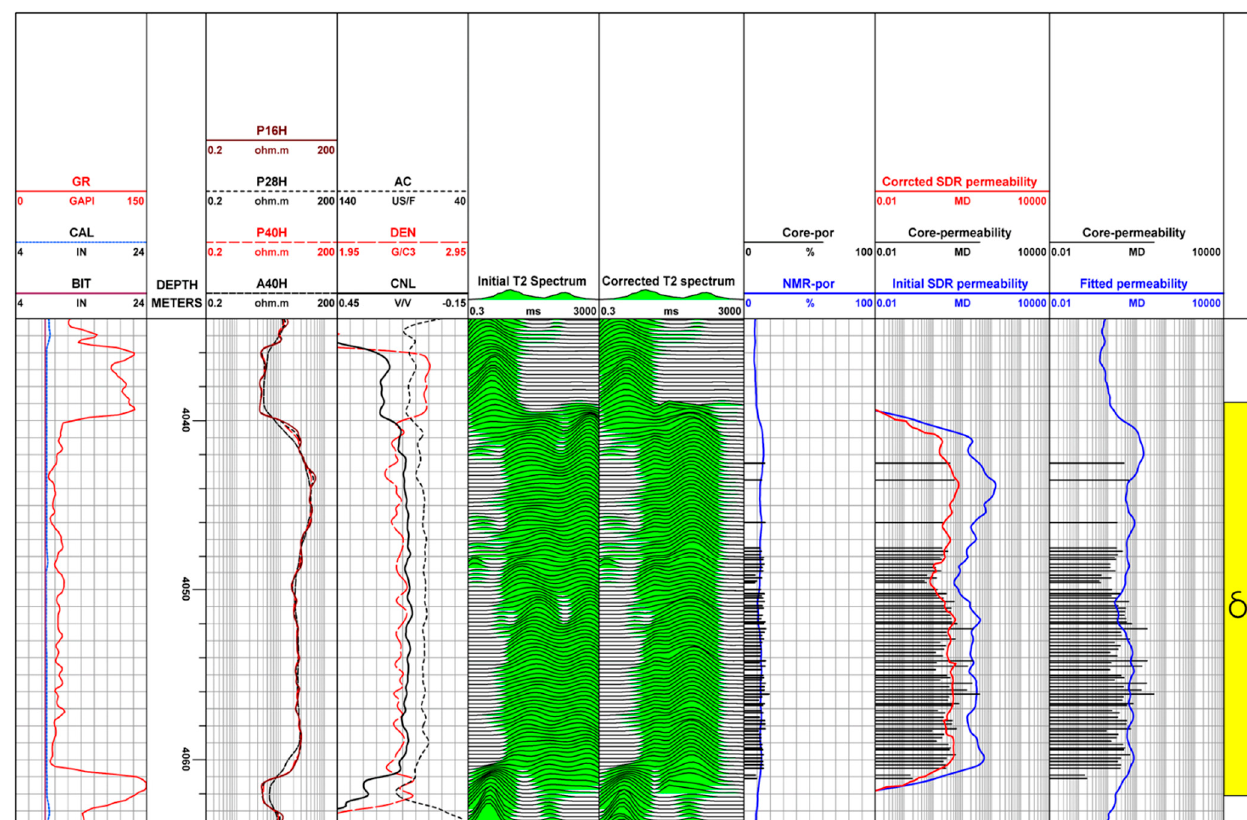
Figure 7. A field example of correcting the invasion of oil-based mud to field NMR logging in well B. In the first track, the displayed curves are gamma-ray (GR), borehole diameter (CAL), and bit diameter (BIT). The second track is the depth. The third is resistivity curve. The acoustic transit time log (AC), the density log (DEN), compensated neutron log (CNL) are shown in the fourth track. The fifth track is the initial measured T 2 spectrum of NMR logging before correction (Initial T 2 spectrum). The T 2 spectrum of nuclear magnetic resonance logging (Corrected T 2 spectrum) under the condition of water-based mud corrected by the method proposed in this study is displayed in the sixth track. The NMR calculated porosity (NMR-por) and core analysis porosity (Core-por) are shown in the seventh track and have good consistency. The Corrected SDR permeability is calculated permeability from the corrected T 2 spectrum by using Schlumberger-doll-Research (SDR) model, and the Initial SDR permeability is estimated permeability from the Initial T 2 spectrum by using the SDR model, the Core-permeability is derived permeability from core analysis. The ninth track is the permeability calculated by using the traditional porosity-permeability relationship (Fitted permeability). Good consistency of estimated permeability from the Corrected T 2 spectrum with core derived permeability illustrates the reliability of the proposed method.